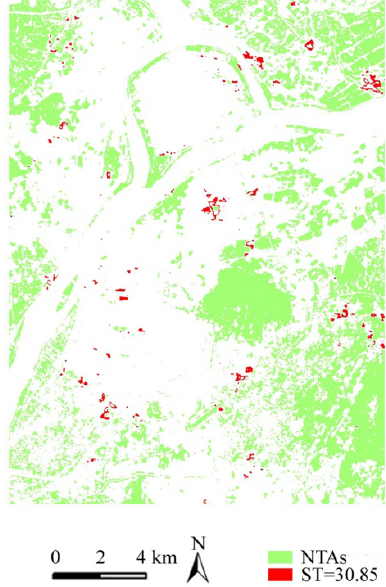
Figure 5. The pattern of the green samples with ST = 30.85